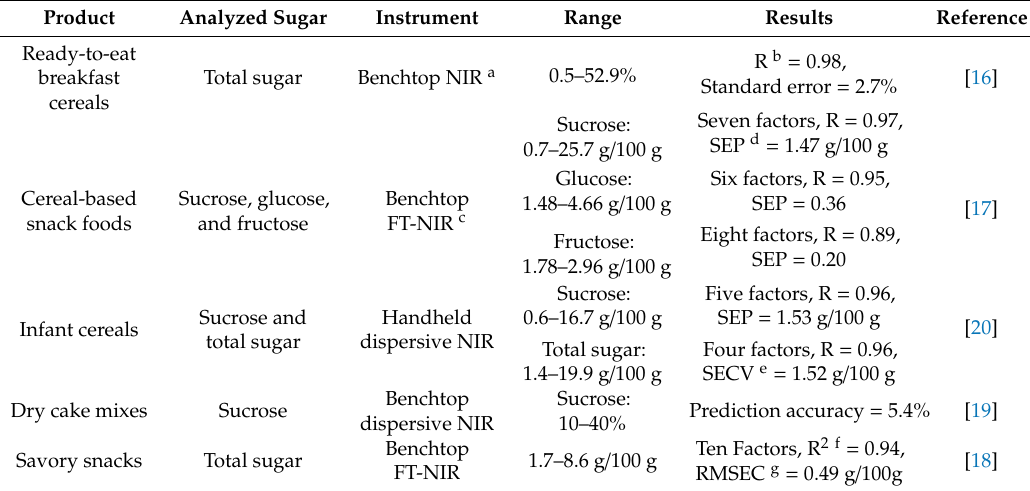
Table 3. Overview of studies performed using NIR spectroscopy to measure total or individual sugar content in cereal-based products, snack foods, and cake